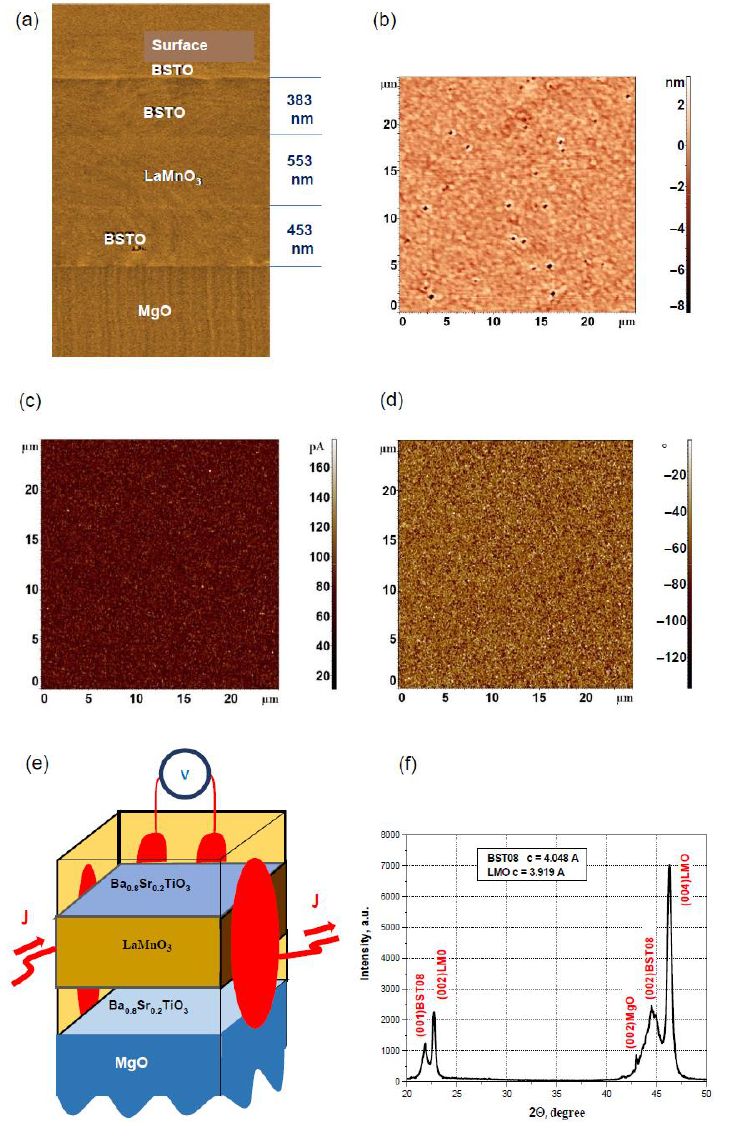
Figure 1. ( a ) STEM image of the BSTO/LMO/BSTO heterostructure; ( b ) the typical topography of the surface of the BSTO film of a virgin heterostructure measured by AFM with the average roughness 0.54 nm; ( c ) the amplitude and ( d ) phase of the vertical component of piezoelectric response on the surface of the BSTO film measured by AFM; ( e ) the scheme of the electrical resistance measurements with the red color schematically showing the placement of the contacts with silver paste and the current and measuring wires; and ( f ) the X-ray diffraction pattern of the heterostructure.